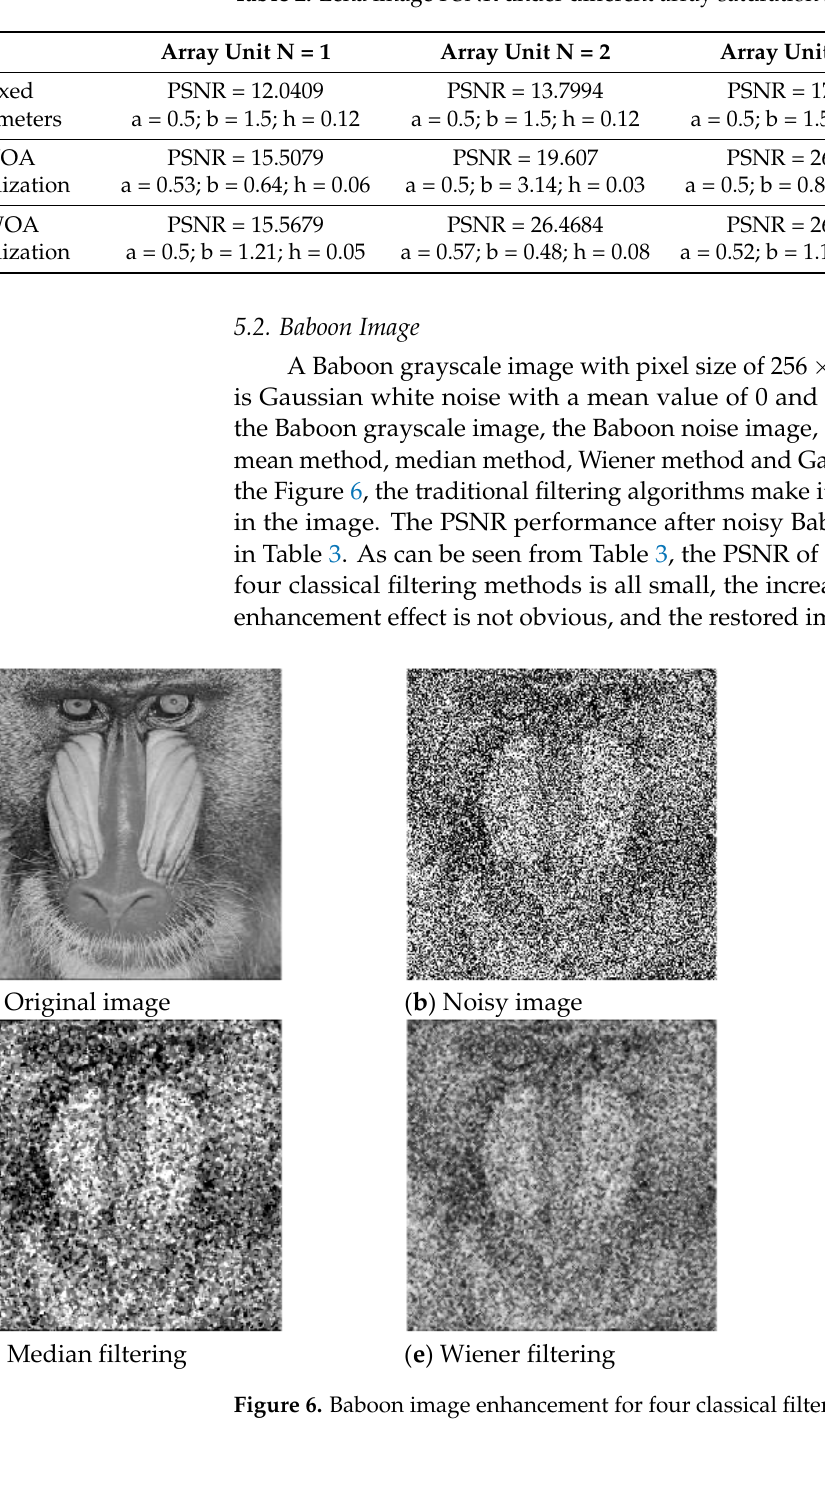
Table 2. Lena image PSNR under different array saturation model methods (dB).